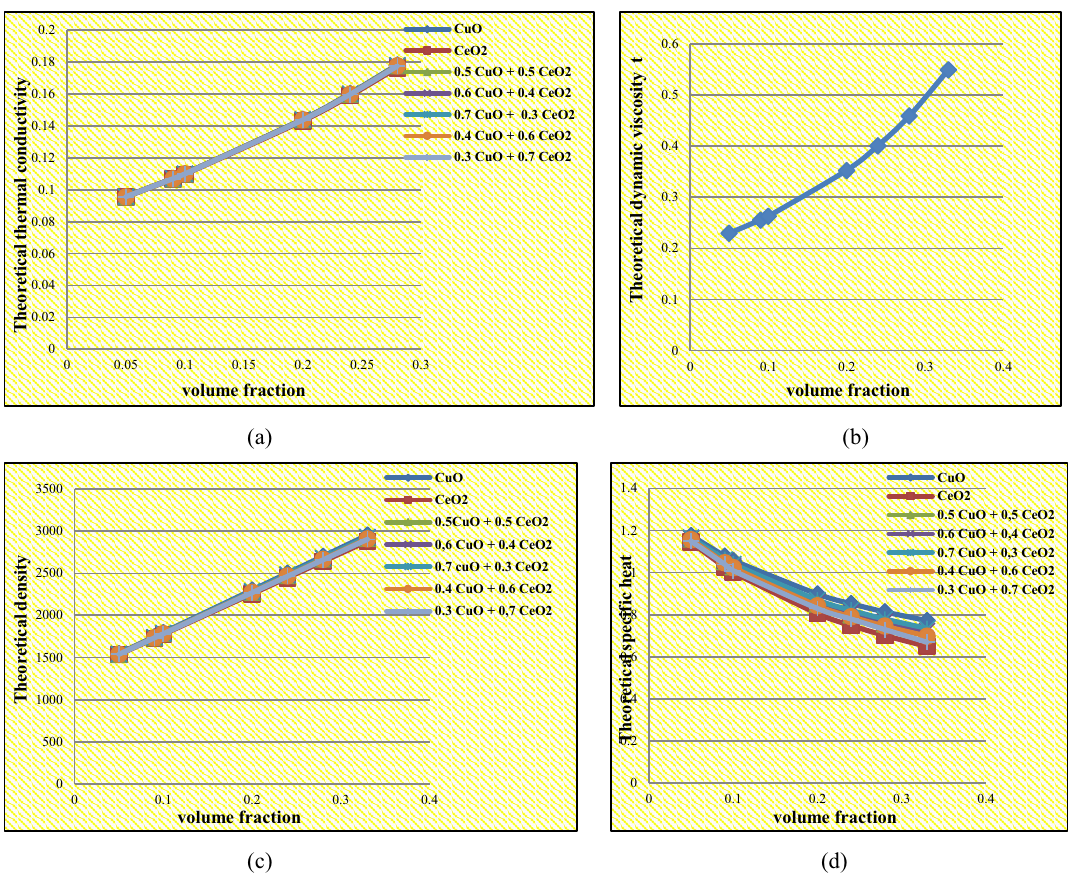
Figure 9. The effects of nanoparticles on the thermophysical properties of the